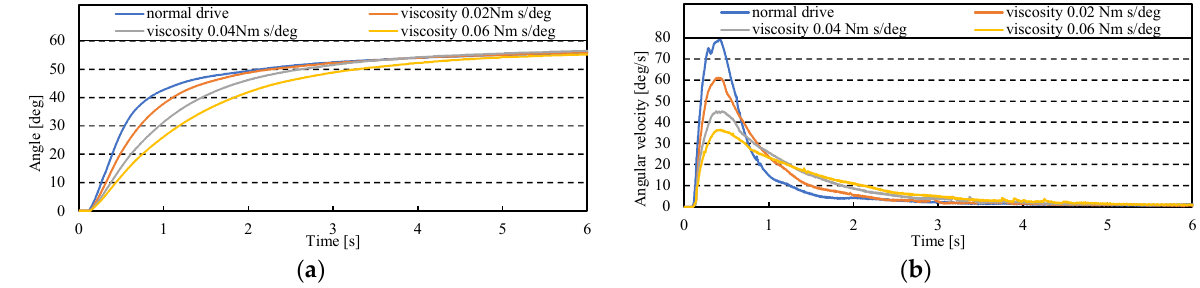
Figure 13. Measurement results of instantaneous drive and normal drive. ( a ) Results of angle. ( b ) Results of angular velocity.